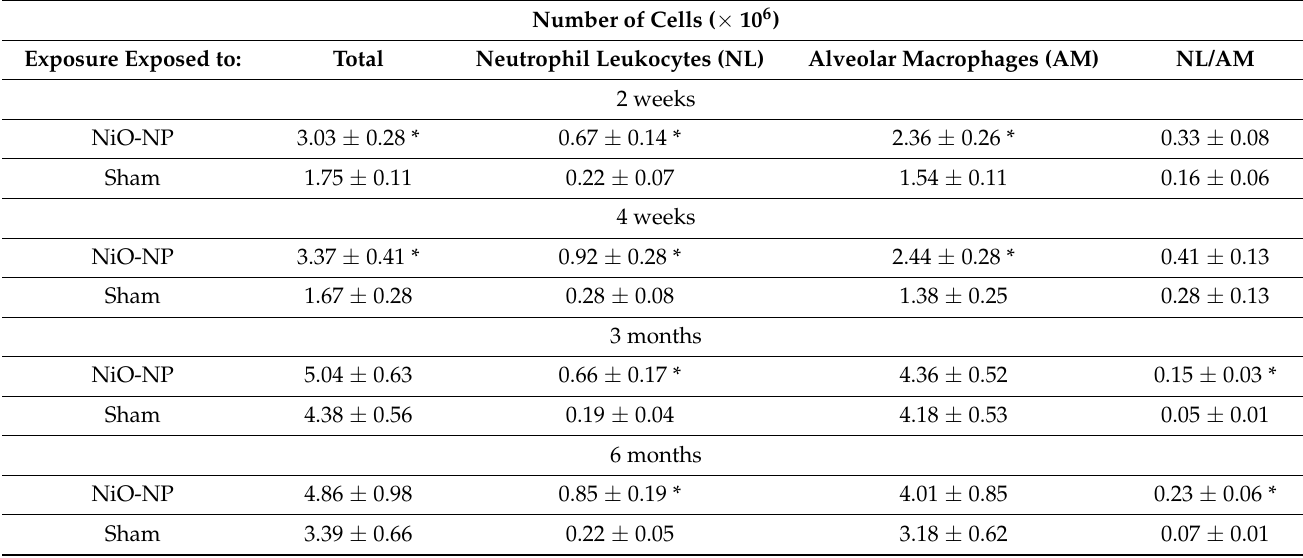
Table 1. Number of cells in the bronchoalveolar lavage fluid (BALF) obtained 24 h after the last 4-h inhalation exposure to nickel-oxide nanoparticles (NiO-NP) at 2.4 ± 0.4 µ g/m 3 ; ( x ± s.e. ).